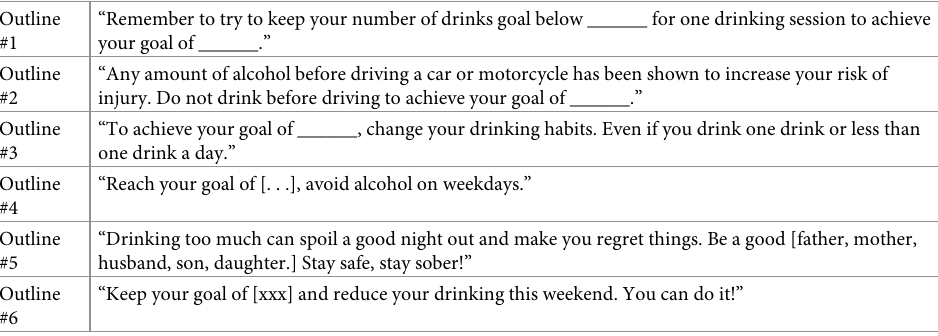
Table 3. Examples of three pre-outlined SMS text messages (translated from Swahili to English) sent to partici- pants in the personalized booster arm. These messages were completed with personalized information collected dur- ing the PPKAY interview.